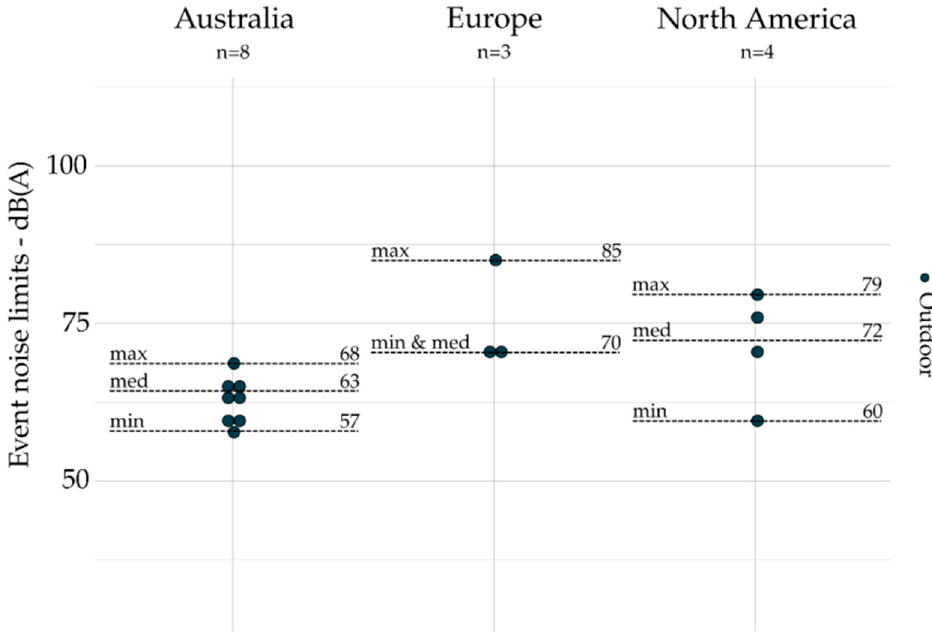
Figure 7. Event indicators for outdoors (all zones combined) and grouped by geographic area ( n =